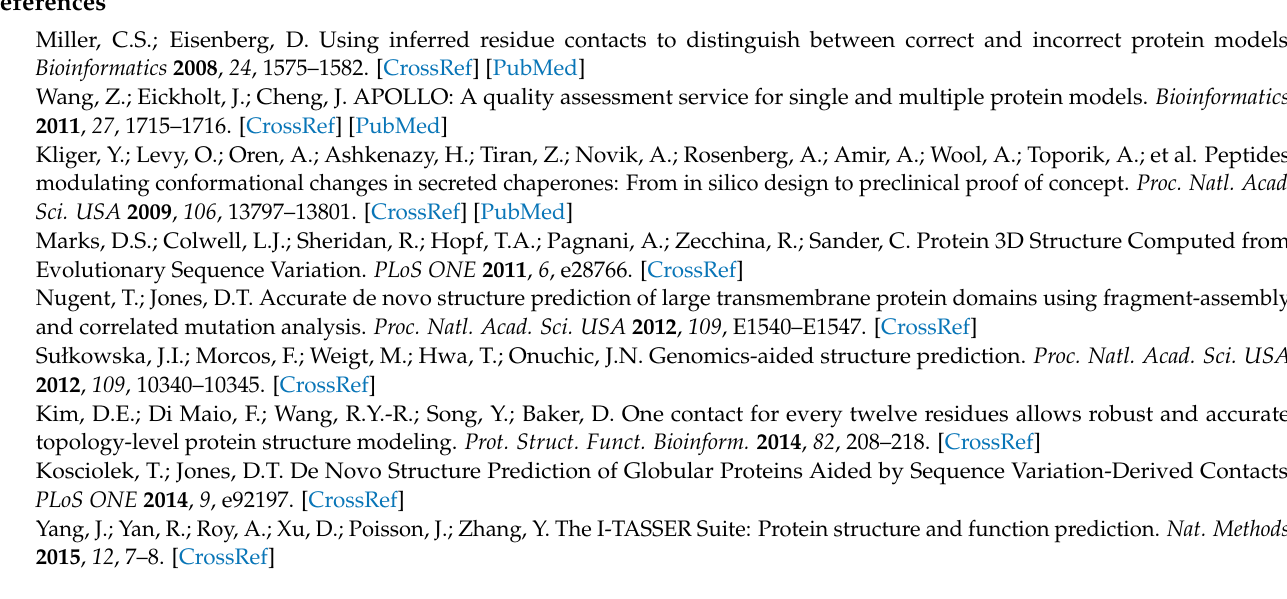
training set of COMTOP, Table S3: 239 non-redundant proteins used for testing, Table S4: 30 CASP13 target domains used for testing, Table S5: 25 CASP14 target domains list used for testing, Table S6: 57 non-redundant TM proteins used for testing, Table S7: Parameters λ ( m 1 ) COMTOP) obtained from the overall training process are shown in columns 1 to 6,